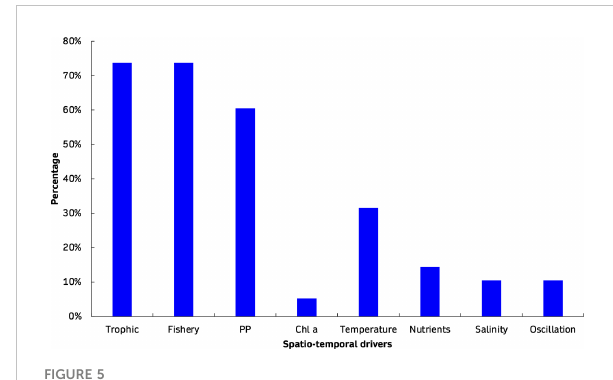
FIGURE 5 Forcing factors used as drivers for spatio-temporal simulations (i.e., Ecosim, Ecospace) in the calibration and fi tting procedures; the y- axis informs on their percentage of